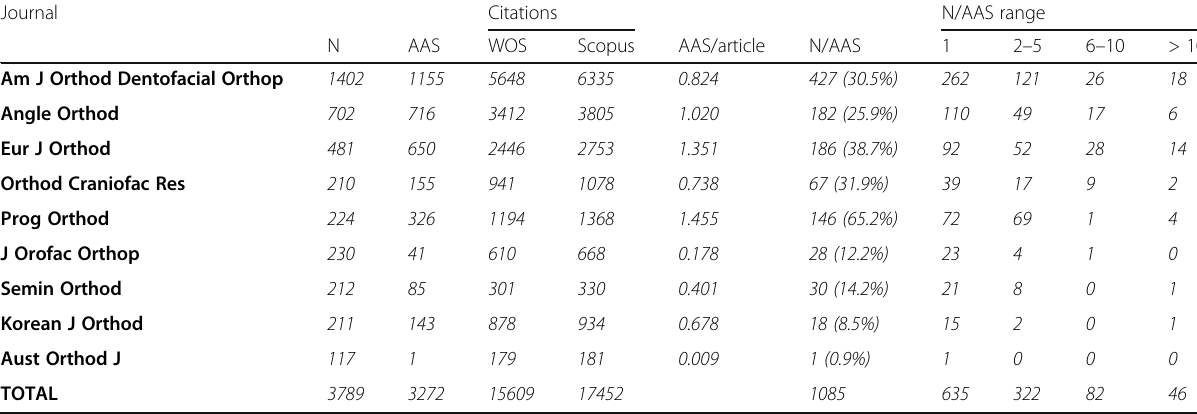
Table 1 Number of published items ( N ), total Altmetric AAS, number of citations in WOS and Scopus, mean AAS per article and number of article with a positive AAS (N/AAS), and AAS range for each of the studied journals are presented. (Journal titles are expressed according to their ISO